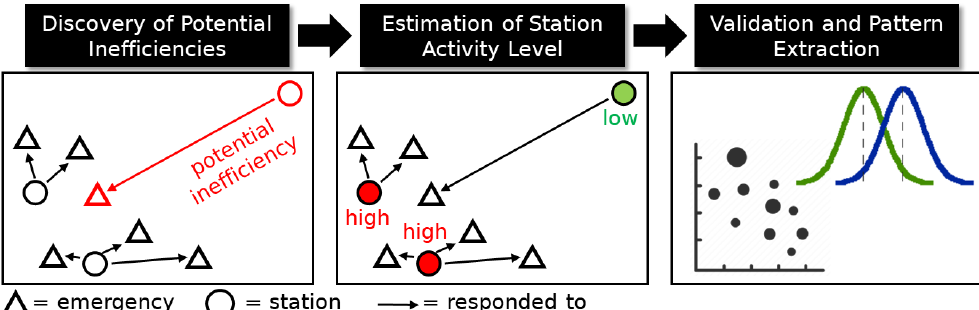
Figure 2. Phases in the discovery and analysis of potential